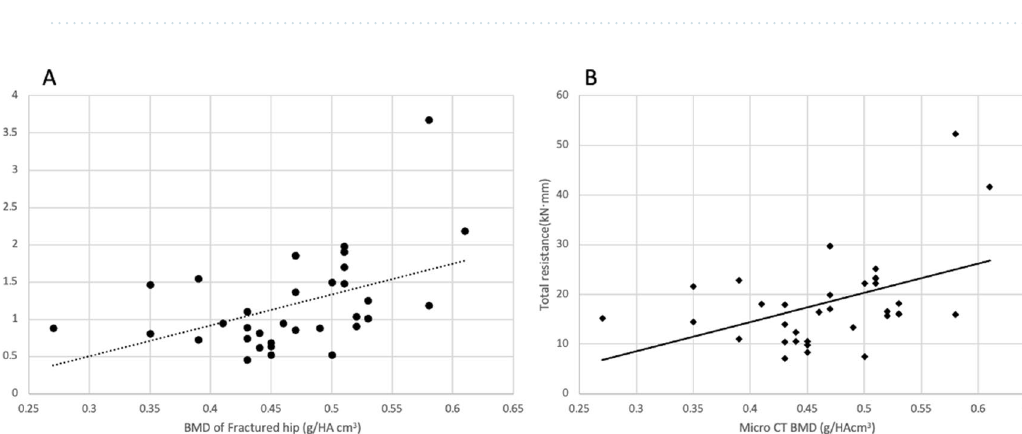
Table 4. Resistance properties of the fractured femoral head measured by mechanical testing. SD standard deviations.